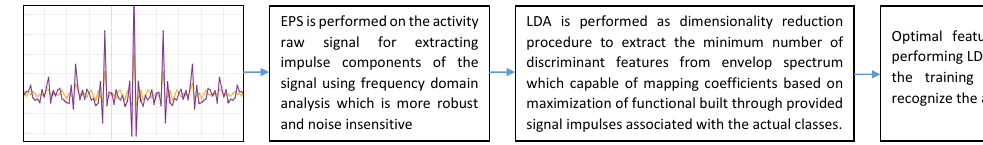
Figure 2. Working procedure of the feature extraction process.